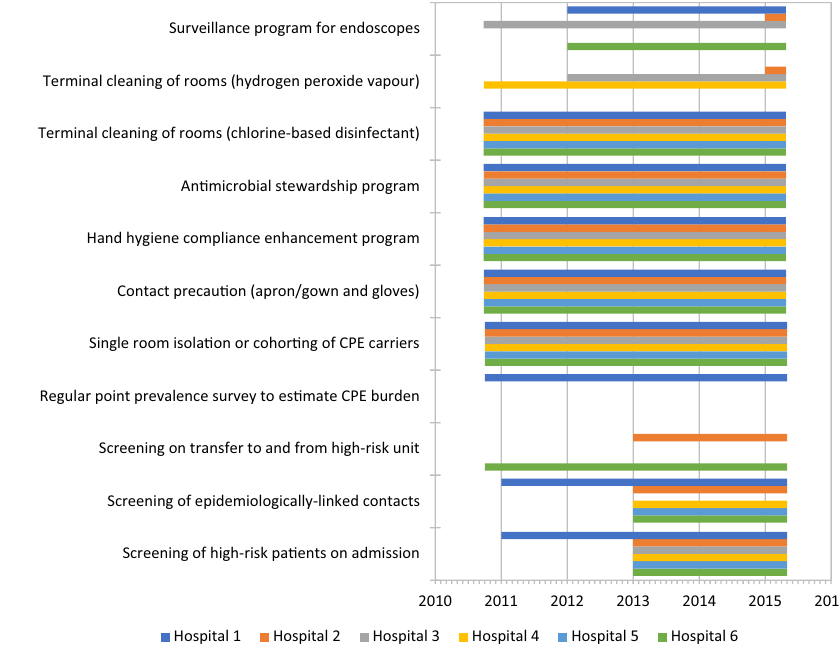
Fig. 3 Staggered adoption of infection-prevention measures at participating study sites over study period (September 2010 to April 2015). The coloured-bars represent the time period of adoption of the various measures with calendar years denoted on the x-axis. Speci fi c measures are listed on the y-axis. The bars are colour-coded to differentiate the various participating